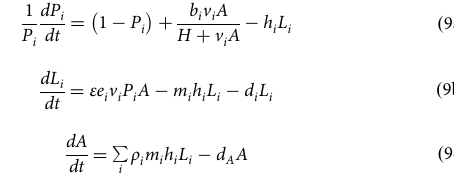
Fig. 3). Parameter space plots show that the interaction transitions from antagonism to net mutualism when the costs associated with host traits underlying attraction ( c H,i V ) and defense ( c H,i H ) are within a range beyond which there is evolutionary purging of the partner (Supplementary Fig. 3a – c). Only with convex trade-offs can the net antagonism persist. The coevolution of mutualism also requires that the costs associated with partner traits underlying visitation ( c F V ) and antagonism ( c F H ) exceed a threshold (Supplementary Fig. 3d – f) below which there is evolutionary purging of the partner (linear or convex trade-offs) or the net antagonism persists (linear or concave trade-offs). Coevolution of mutualism occurs across greater parameter ranges when the trade-offs are linear or slightly concave because costs increase less rapidly than with convex trade-offs. Ecological model of plant-insect interactions . We tailor the general model (Eq. 4) to model populations of D. wrightii (density P w ) and D. discolor (density P d ) interacting with M. sexta . We scale the model so that P i = 1 in the absence of M. sexta : thus, P i >1 indicates that pollination bene fi ts exceed herbivory costs, and P i < 1 indicates that herbivory costs exceed pollination bene fi ts. The Datura species do not rely obligately on M. sexta and, consistent with ecology of the natural community (Box 1), the model incorporates the alternative host plant, Proboscidea parvi fl ora (density P p ), and the alternative nectar source, Agave palmeri . The ecological dynamics of this community (without evolution) are given by: